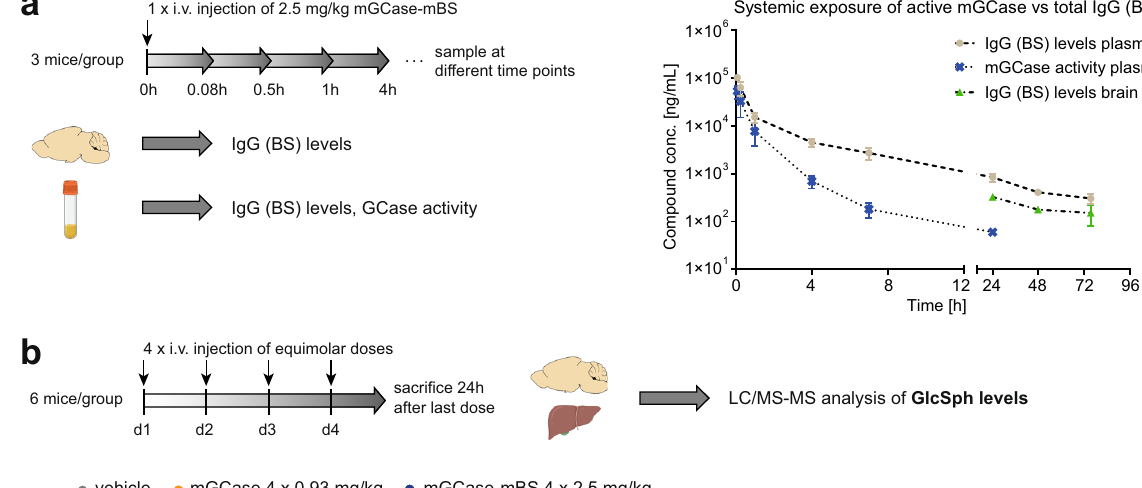
treatment. Graph showing increased or decreased levelsof lysosomal lipid species in GBA − / − cells (blue bar) and its rescue upon hGCase-hBS treatment (yellow bar). Note: The lipid analysis performed does not report the number of carbons in the sphingoid base and the acyl chain (fatty acid chain) separately. Hence, the fi rst numberinthenomenclatureusedreferstothetotalnumberofcarbons(sphingoid base+acyl chain). An Excel sheet consisting of each of the detected lipid species anditscorrespondingSwisslipidsIDisprovidedinSupplementaryDataFile3.FDR- corrected p -values are shown in ( c ) and ( d ) (** q -value <0.01; * q -value <0.05; n =3 independent measurements), calculated for each contrast separately. Trends are also displayed (e.g. signi fi cance found in one contrast only), to highlight potential lipid/proteinentitieswithoppositefoldchangein GBA − / − andrescueuponhGCase- hBS treatment. Source data are provided as a Source Data fi le. Schematics created with BioRender.com.